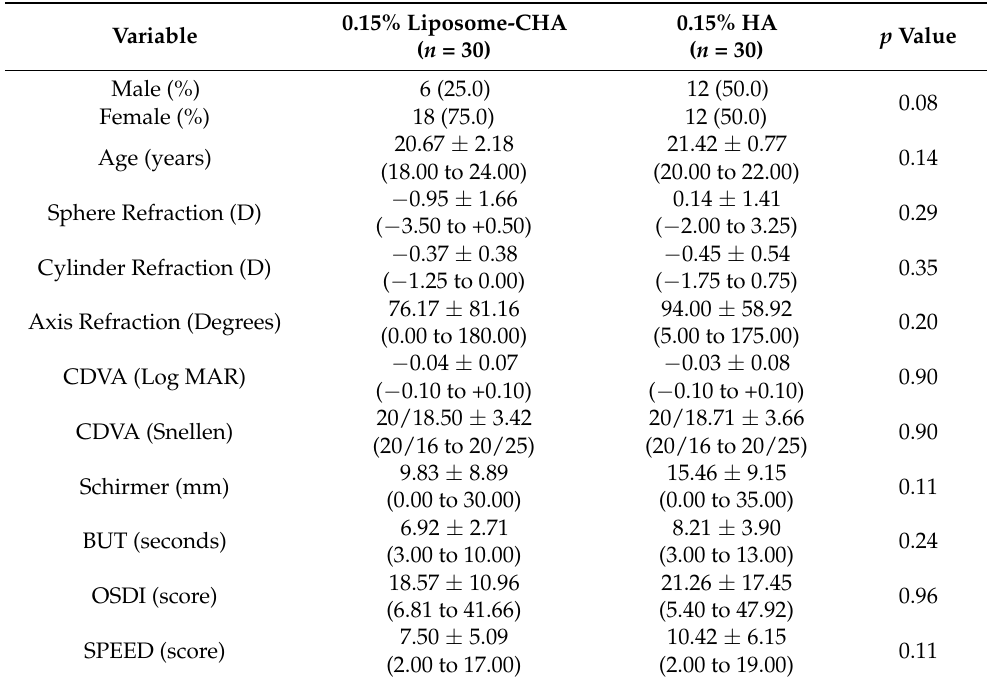
Table 1. Demographics and baseline subjects’